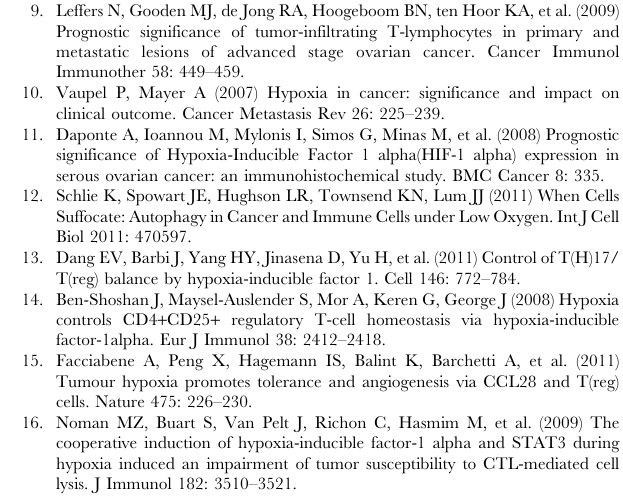
Figure S2 Vascularized tumors containing TIL and functional markers show a modest association with improved patient survival. (A) CD31 and CD4, (B) CD31 and Granzyme B (GzmB), (C) VEGF and CD4, (D) VEGF and FoxP3,